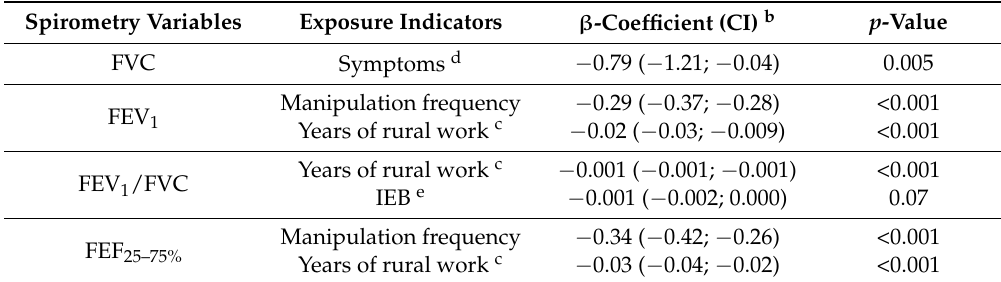
Table 5. Multiple regression models a of spirometry variables (in percentages of predict) on exposure indicators during the off-season in SJU.